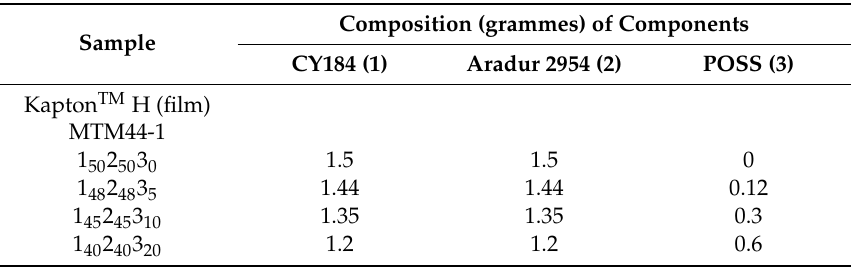
Table 2. The compositions of the chemical blends used in this work.